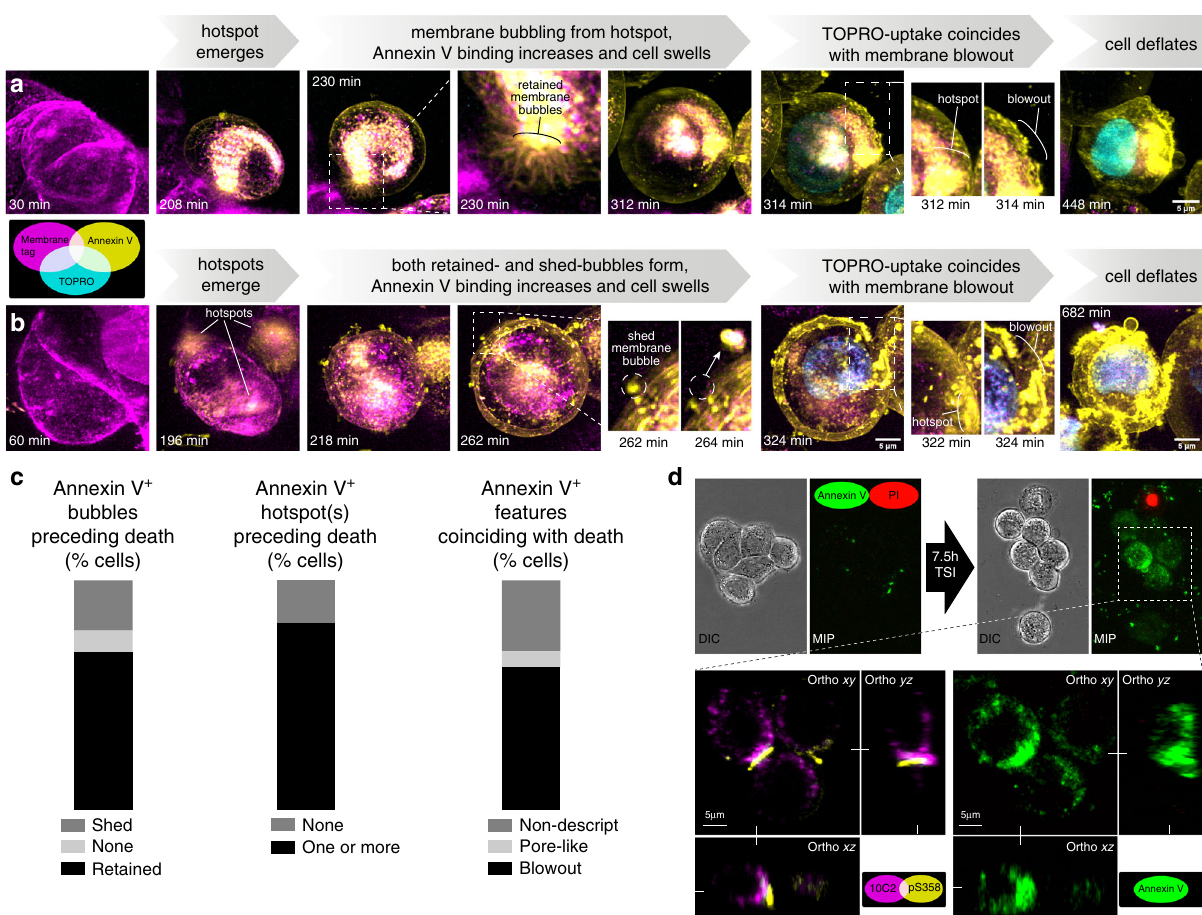
Fig. 4 Membrane damage at MLKL hotspots promotes cell death. a – c Time-lapse lattice lightsheet microscopy of TSI-treated HT29 cells expressing mTagRFP-Membrane-1 fusion protein (magenta; plasma membrane) with Annexin V-binding (yellow; membrane damage) and TOPRO-uptake (cyan; cell death). Micrographs are maximum intensity projections (MIP). Plots in c show the percentage of cells that shed or retained bubbles or formed hotspots preceding death, or featured membrane blowout or pore-like structures contemporaneously with death. Data from N = 32 cells across n = 4 independent experiments for events preceding death and N = 29 across n = 3 independent experiments for events coinciding with death. d HT29 cells were TSI-treated and Annexin V-binding (Annexin V; green) and propidium iodide-uptake (PI; red) were measured via time-lapse DIC and 3D confocal microscopy. After 7.5 h of TSI-treatment, cells were immunostained for MLKL 10C2 and MLKL pS358 . Annexin V-binding during TSI-treatment in MIP; orthogonal